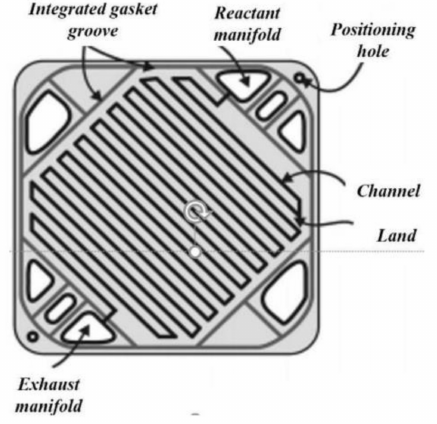
Figure 1. Part of a flow plate [3].